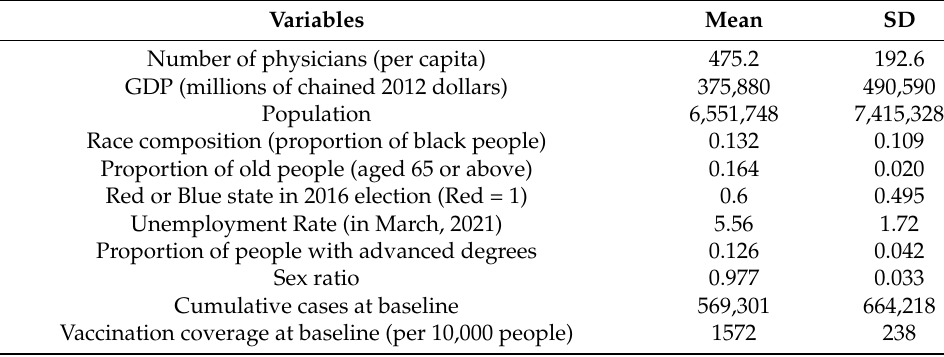
Table 1. Descriptive statistics of baseline covariates.